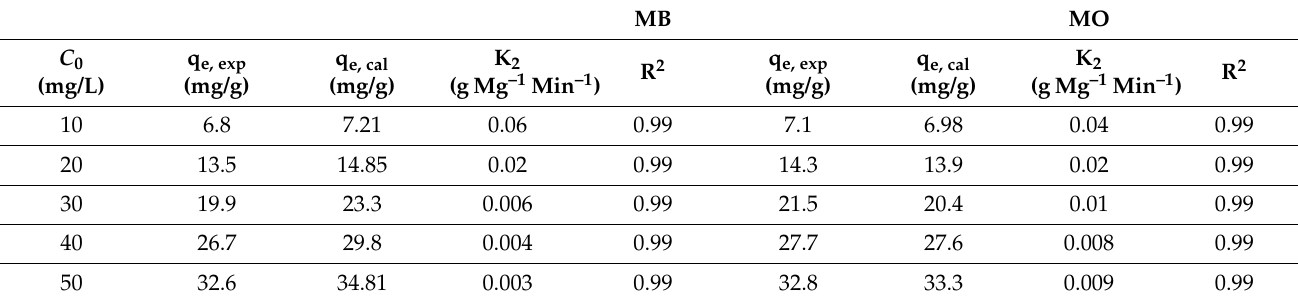
Figure 11. Pseudo-second-order Model for the adsorption of ( a ) MB and ( b ) MO with different initial concentrations. Table 3. Pseudo-second-order kinetic parameters for MB and MO adsorption by Kg-Ch sponge.